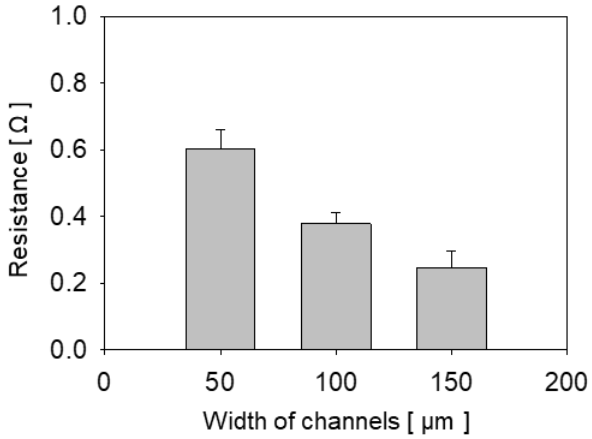
Figure 12. Graph of measured resistance for each width of deposited copper wire inside a channel. Average resistivity of 87.52 µ ·cm was calculated based on the assumptions that 50 µm thick